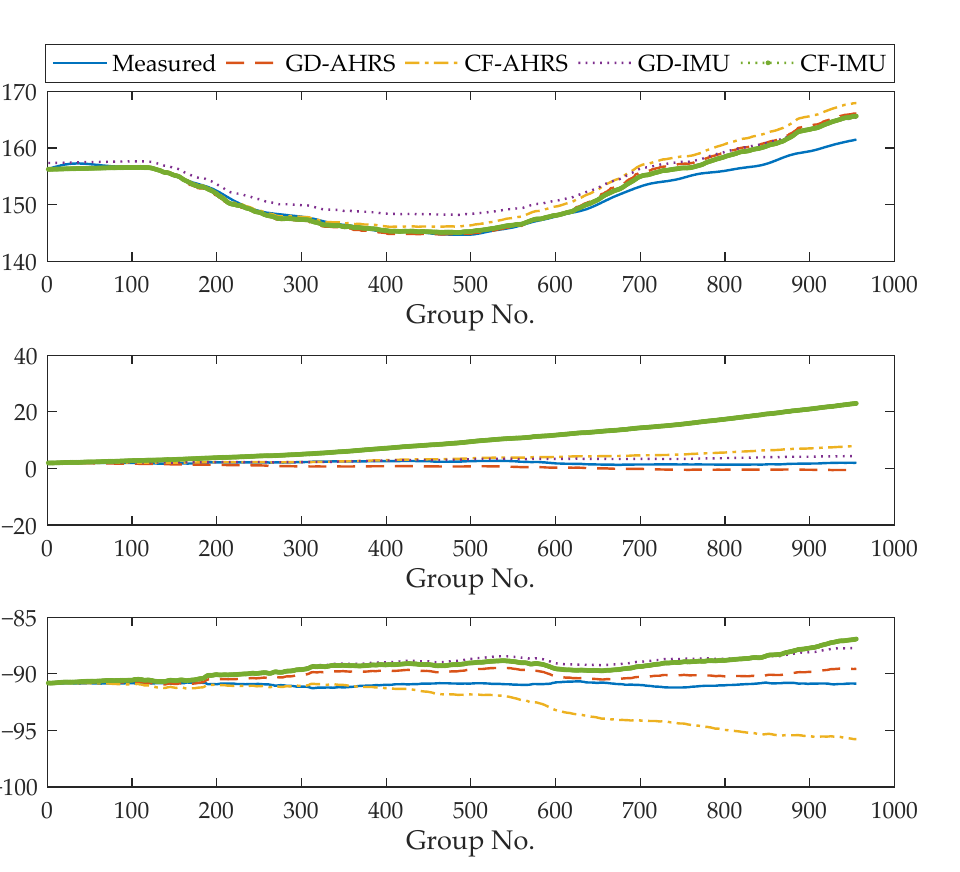
Figure 8. Comparison of AHRS and IMU Attitude Solution Results of Gradient Descent (GD) and Complementary Filtering (CF).